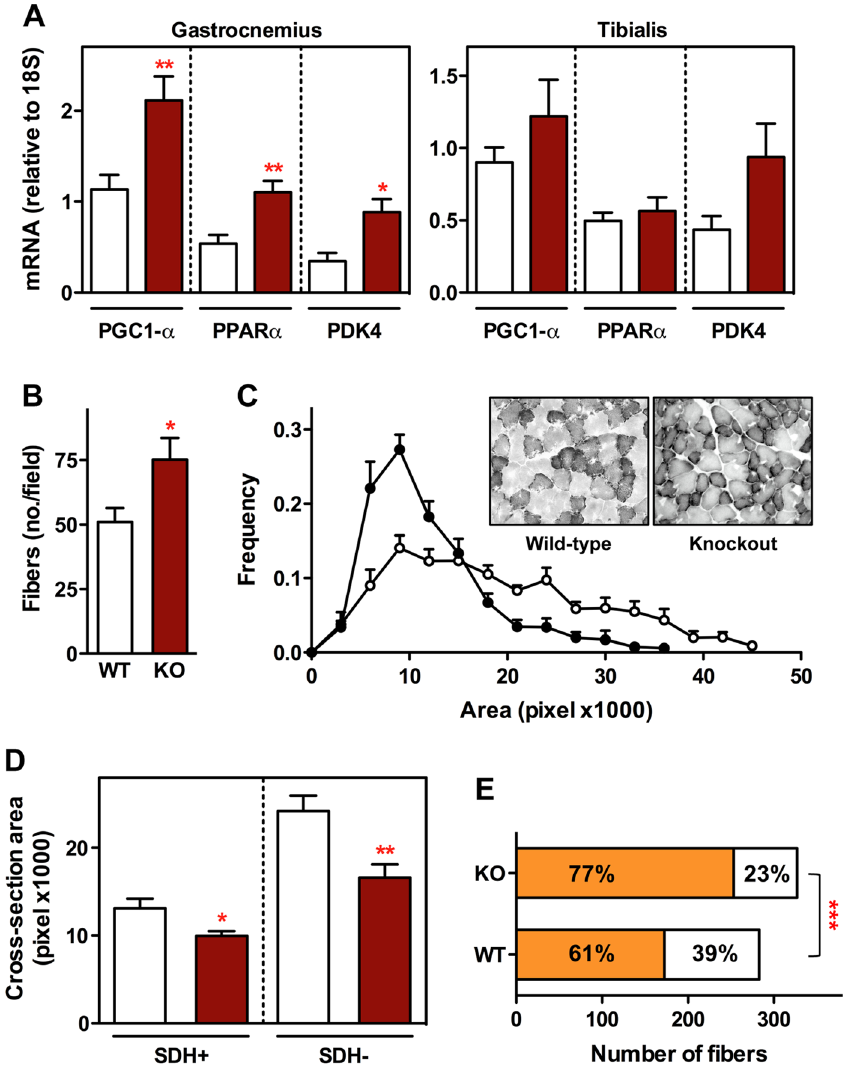
Figure 3. Metabolic phenotype of muscle from SCD1 knockout mice. (A) Expression of PGC1- a , PPAR a and PDK4 in gastrocnemius and tibialis anterior from SCD1 knockout mice (brown columns) and wild-type littermates (white columns). * P , 0.05, ** P , 0.01 (Unpaired t-test, n=3–11). (B) Number of muscle fibers in tibialis anterior from SCD1 knockout mice (KO, brown column) and wild-type littermates (WT, white column). * P , 0.05 (Unpaired t-test, n=7–10). (C) Distribution of the calibers of muscle fibers in tibialis anterior from SCD1 knockout mice (327 fibers, black circles) and wild-type littermates (283 fibers, white circles). Representative microphotographs of wild-type and knockout tibialis anterior are shown. (D) Averaged cross-sectional area of SDH-positive and SDH-negative fibers in tibialis anterior from SCD1 knockout mice (brown columns) and wild-type littermates (white columns). * P , 0.05, ** P , 0.01 (Unpaired t-test, n=7–10). (E) Number of SDH-positive (orange bars) and SDH-negative fibers (white bars) in tibialis anterior from SCD1 knockout mice (KO) and wild-type littermates (WT). *** P , 0.001 (Chi-square test,